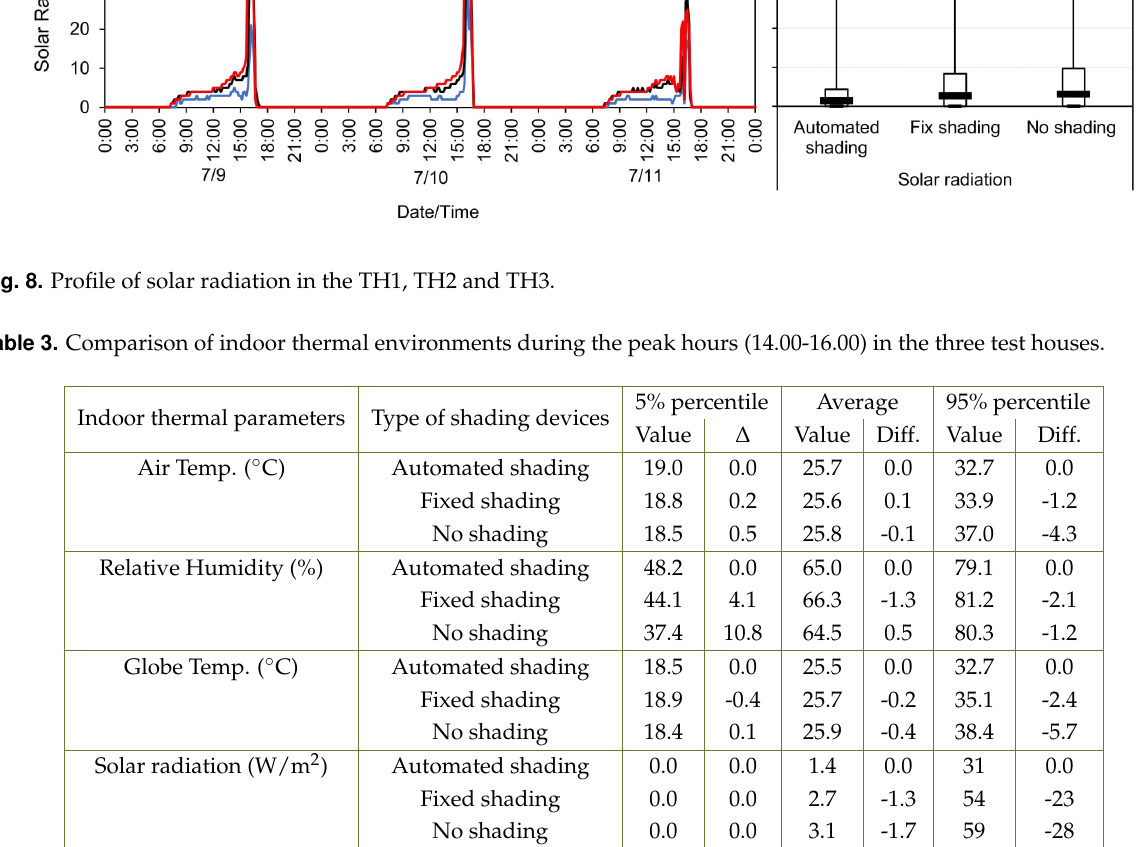
Solar radiation (W/m 2